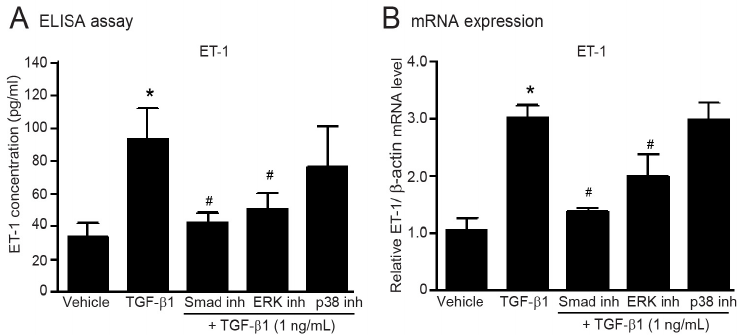
Figure 6. TGF- β 1 induces the secretion and production of ET-1 via Smad- and ERK1/2-dependent pathways . Serum-starved adult HCFs were pretreated with 1 µM Smad inhibitor (Smad inh), 1 µM FR180204 (ERK inhibitor; ERK inh), or 1 µM SB203580 (p38 MAPK inhibitor; p38 inh) for 1 h before treatment with 1 ng/mL TGF- β 1 for 24 ( A ) or 6 h ( B ). ( A ) After TGF- β 1 treatment, the culture medium was collected. The amounts of ET-1 secreted into the culture medium were determined by ELISA. ( B ) Relative mRNA levels of ET-1 were analyzed by qRT-PCR. Data are expressed as the mean ± SEM ( n = 4). * p < 0.05 vs. vehicle; # p < 0.05 vs. TGF- β 1.